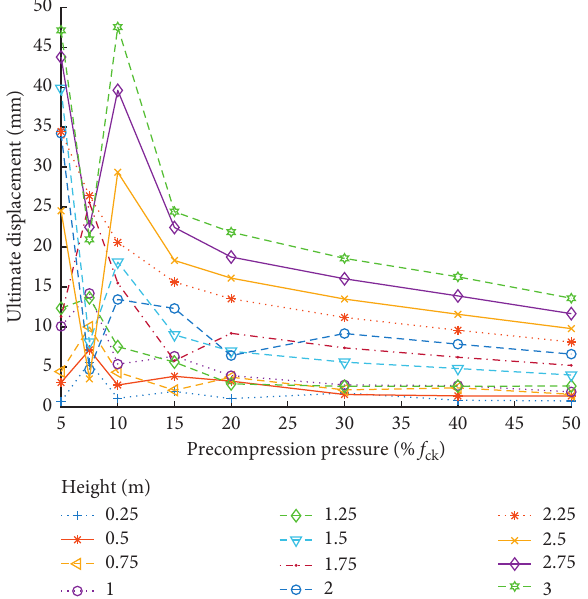
Figure 14: Ultimate displacement vs precompression ratio for different heights.